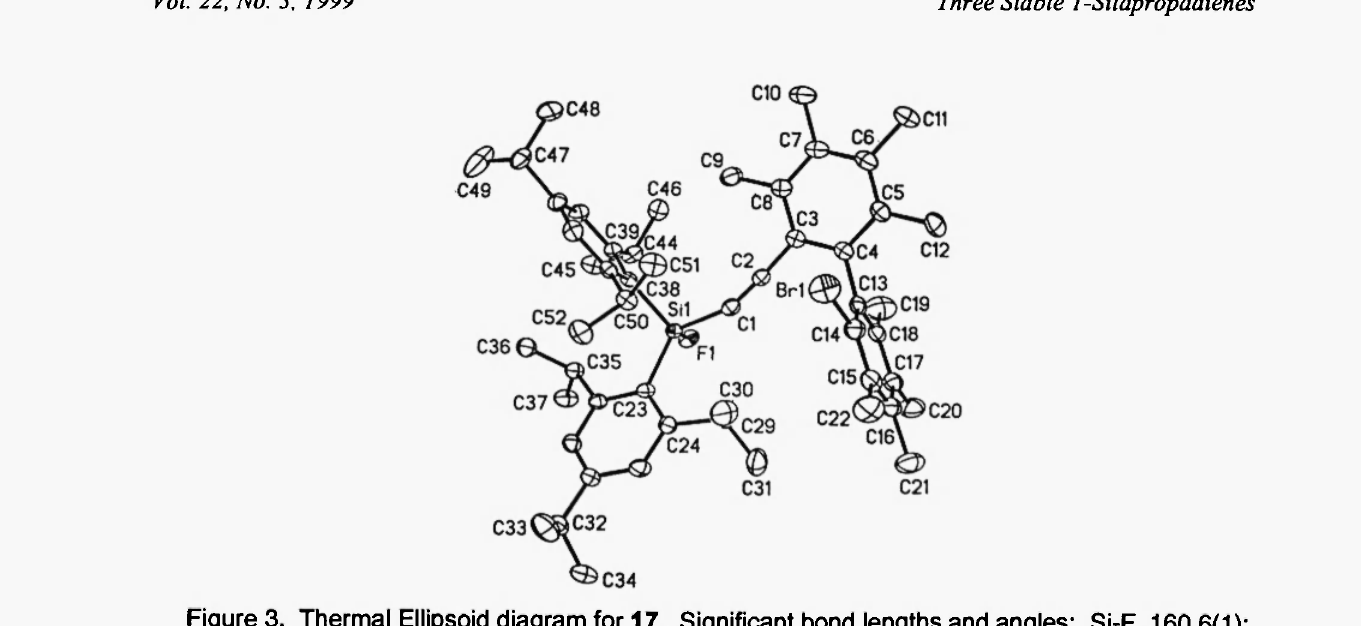
Figure 3. Thermal Ellipsoid diagram for 17. Significant bond lengths and angles: Si-F, 160.6(1); Si-C1, 182.5(2); C1-C2, 121.2(3); C2-C3, 144.4(3); Si-C1-C2, 159.6(2); C1-C2-C3,